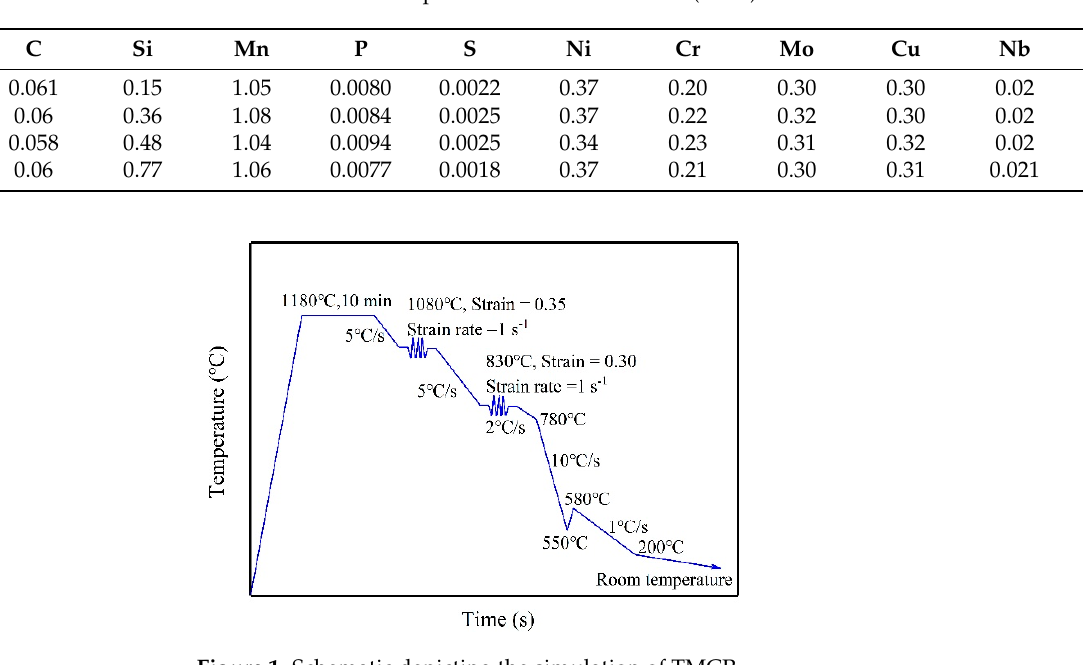
Figure 1. Schematic depicting the simulation of TMCP. Micro-tensile tests were performed at room temperature on a universal tensile testing machine with a load of 3 KN and an extension rate of 0.3 mm/min. The sampling points and dimensions of micro-tensile samples are shown in Figure 2.